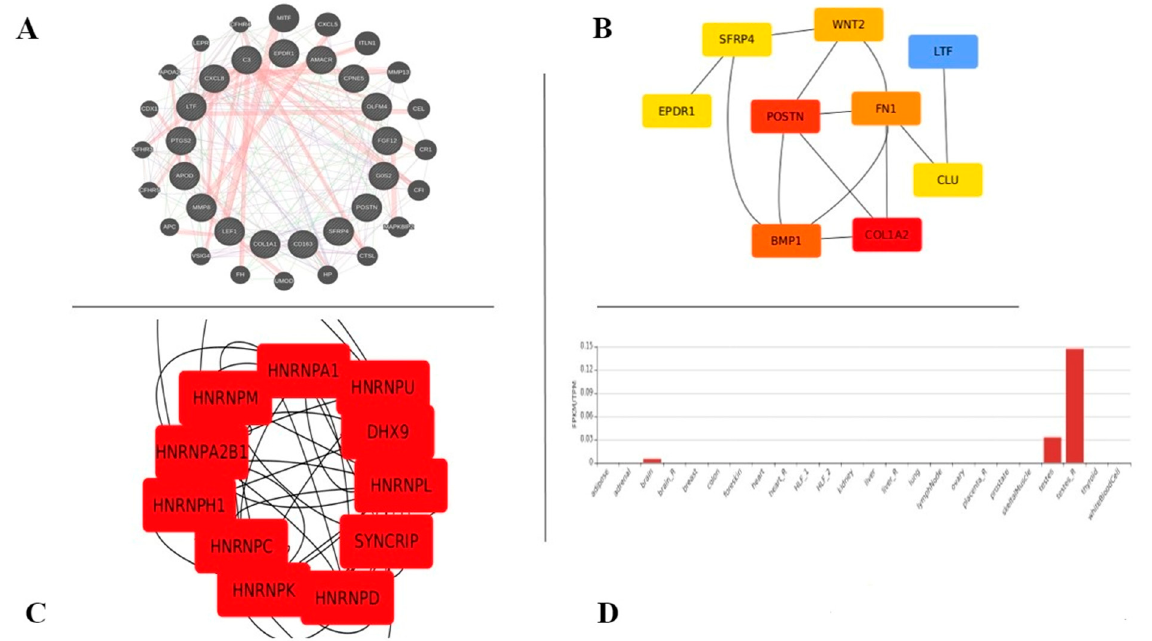
Figure 3. ( A ) The network illustrates the interaction between the differentially expressed genes in all three datasets (myocardial, prostate and renal), and it was constructed with GeneMANIA. ( B ) The network image represents the clustering coefficient of common DE genes from all three datasets. The image was generated with cytoHubba. ( C ) The top ranks of lncRNAs in clustering coefficient networks. ( D ) The graph shows the tissue expression of common novel lncRNA, and it is generated with the NONCODE database.